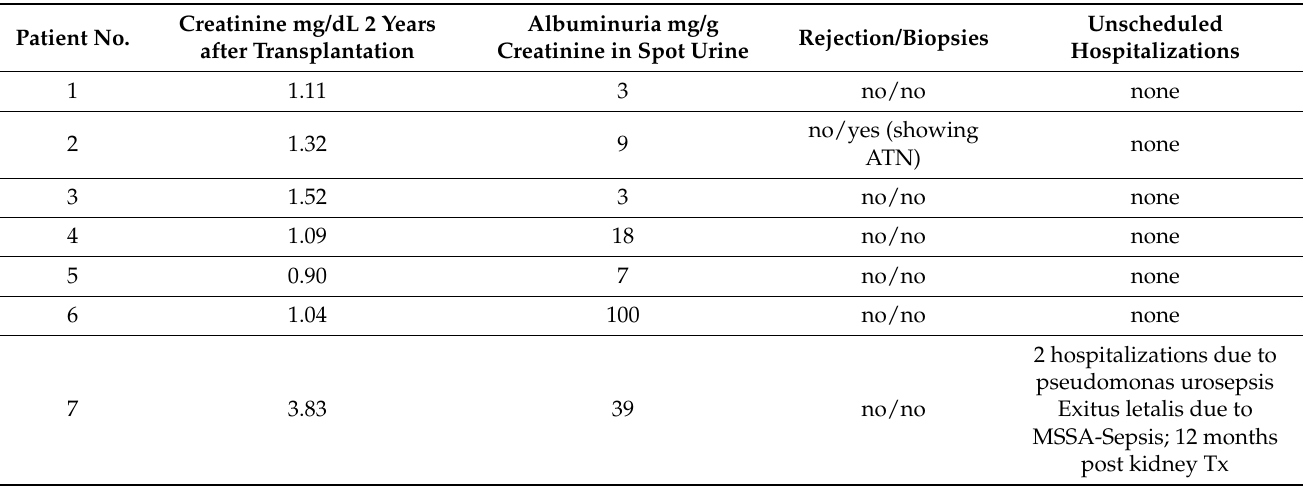
Table 4. Long-term